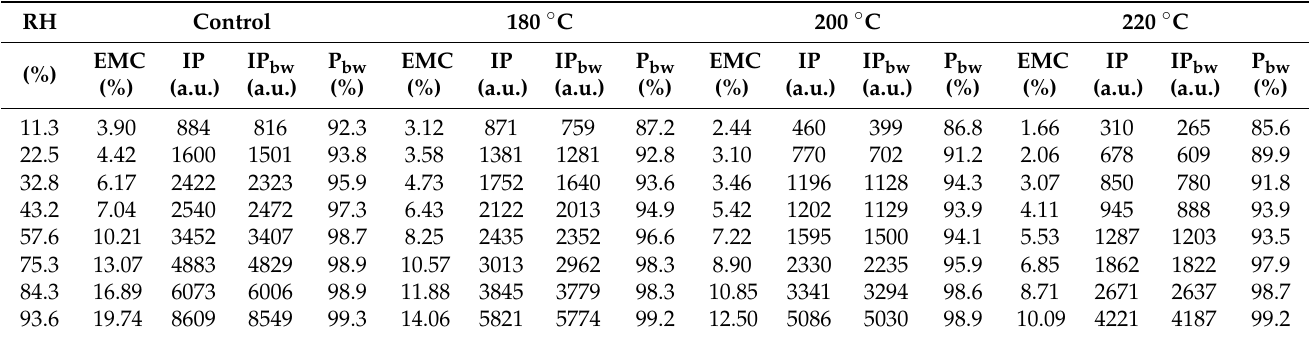
Table 4. The integral of all peaks (IP) and bound water peak (IP bw ) and the proportion of bound water (P bw ) at different